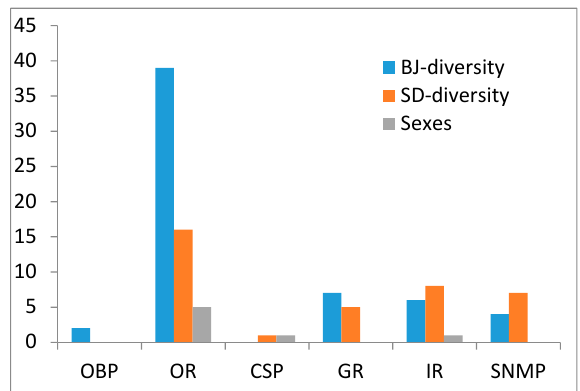
Figure 4. Three categories of collected conserved SNPs. BJ, Beijing; SD,